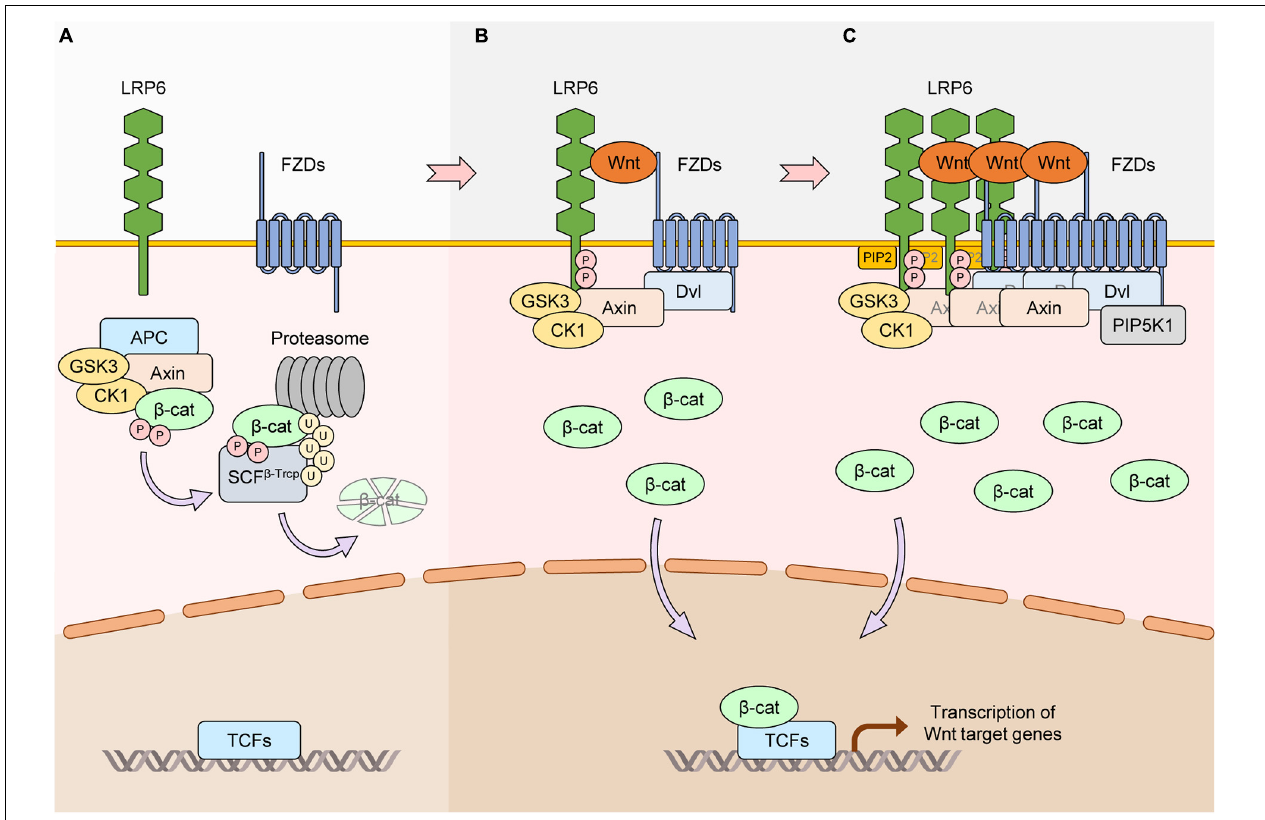
FIGURE 1 | Core activation mechanisms of LRP6 via Wnt stimulation. (A) In the absence of Wnt, the scaffold protein Axin together with APC, GSK3, and CK1 form the β -catenin destruction complex. β -catenin interacts with the complex and is phosphorylated by GSK3 and CK1 α (CK1). Phosphorylated β -catenin is ubiquitinated by SCF β - Trcp and degraded by the proteasome. Protein levels of β -catenin thus remain low, and β -catenin-dependent transcription of Wnt/ β -catenin target genes is suppressed. (B) Wnt interacts with the FZD and LRP6 receptors. Axin-bound GSK3 and CK1 γ phosphorylate PPPS/TP motifs in the intracellular domain of LRP6. Phosphorylated LRP6 serves as a docking site for Axin, facilitating the interaction between Axin and LRP6 and inhibiting the kinase activity of GSK3. This causes the dissociation and inactivation of the β -catenin destruction complex, leading to β -catenin stabilization and activation of Wnt/ β -catenin target gene transcription. (C) Treatment of Wnt induces LRP6 aggregates in a DVL-dependent manner. In this condition, FZDs, Axin, and GSK3 can also aggregate with LRP6, generating LRP6 signalosomes. PIP 2 is generated via DVL-bound PIP5K1. PIP 2 accelerates the formation of LRP6 signalosomes and phosphorylation of LRP6, resulting in further activation of Wnt/ β -catenin